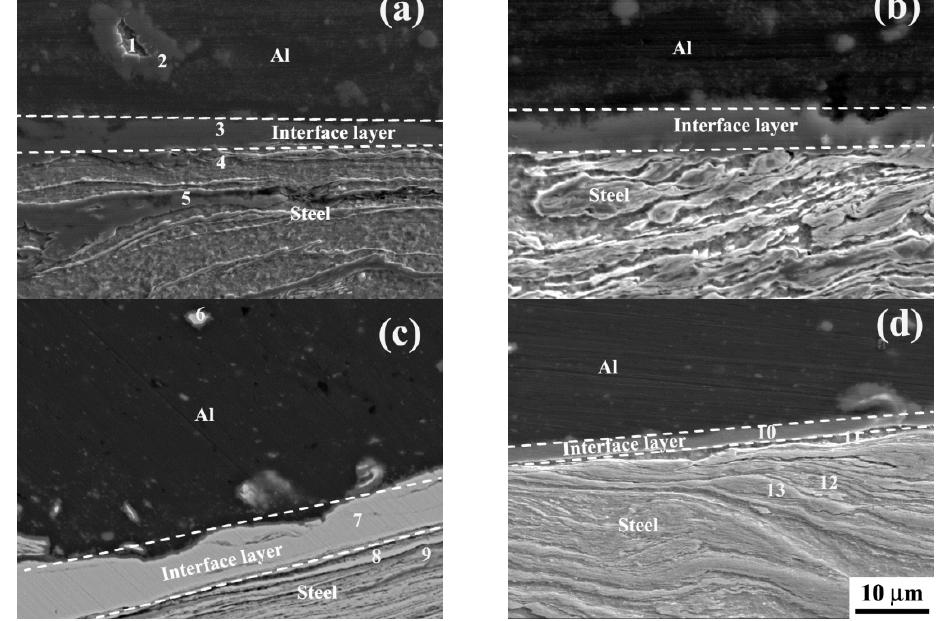
Figure 4. Interfacial microstructure of the Al/steel joints for ( a – d ) processes I, II, III and IV.